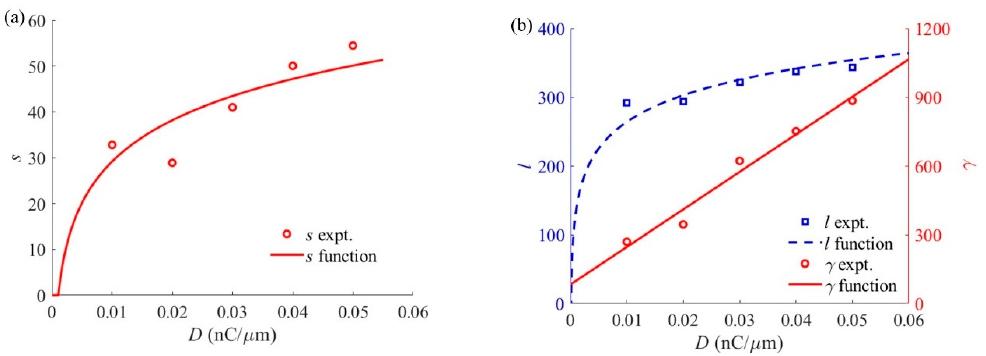
Figure 6. Variation of the DPF coefficients with ion dose at a beam energy of 35 keV: ( a ) Coefficient s ; ( b ) Coefficients l and γ .